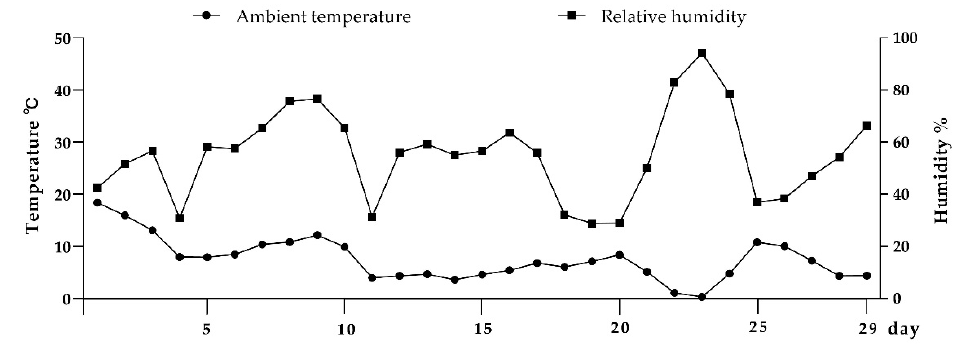
Figure 3. Weather conditions within the barn in Experiment 1. Table 3. Physical properties of peanut shells, a peanut shell–rice husk combination, and rice husks when used as dairy cow bedding